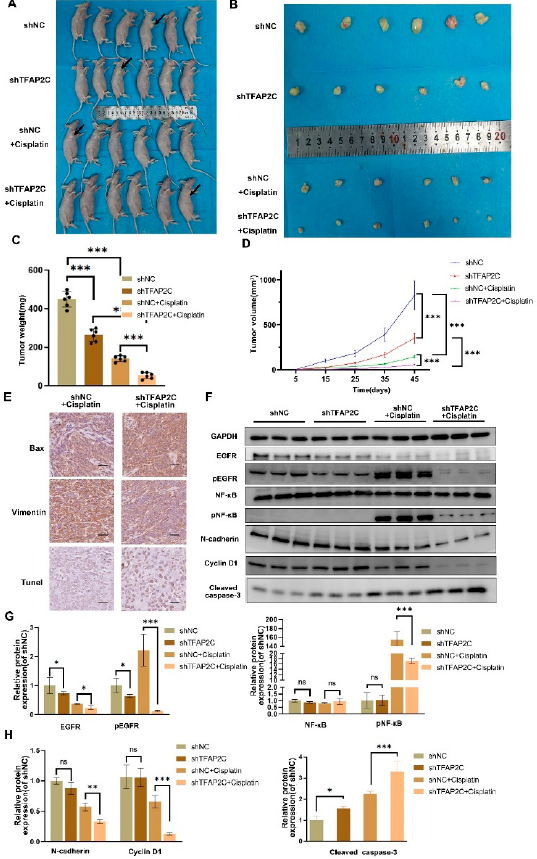
Figure 9. TFAP2C knockdown alone or combined with cisplatin inhibits BCa cell growth in vivo. ( A ) Images of tumors in nude mice after different treatments. Arrows indicate the subcutaneous tumors. ( B ) Morphology of the subcutaneously implanted tumor. ( C ) Tumor weight. ( D ) Vol- ume of tumor at each time point. ( E ) Representative images of TUNEL staining and IHC stain- ing for Bax and vimentin in the cisplatin alone and cisplatin combined with TFAP2C knockdown groups. Scale bars, 20 µ m. ( F – H ) Expression levels of major proteins in different groups. Data repre- sent the mean ± standard deviation (SD) of three independent experiments (* p < 0.05, ** p < 0.01, *** p < 0.001, ns, not